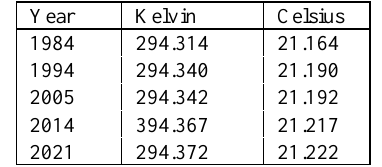
Table 3. Calculated average temperature for the years 1984 to 2021 in Kelvin and degrees Celsius for the control area.